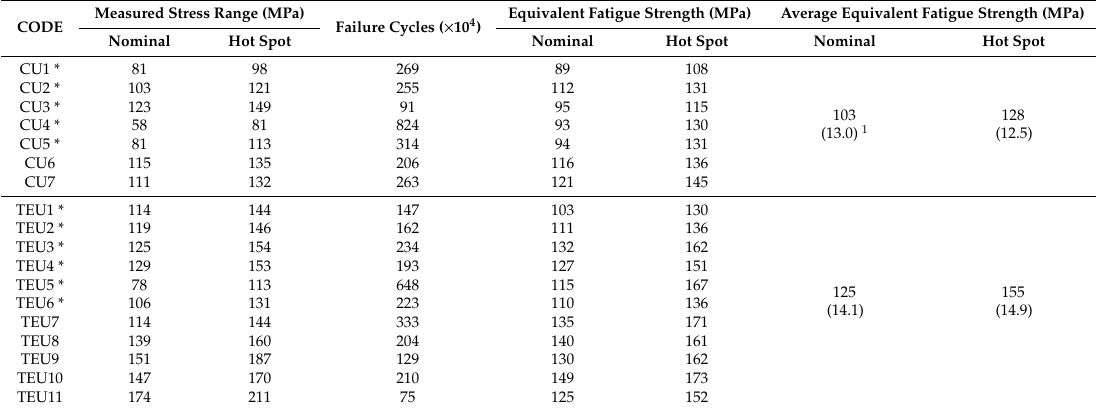
Table 2. Stress–life data measured from fatigue